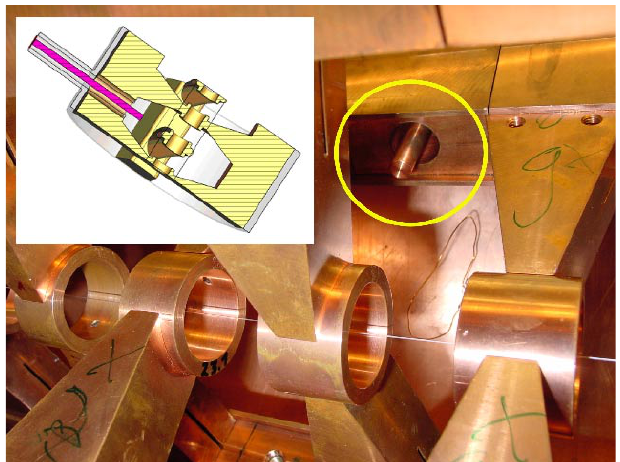
FIG. 14. (Color) The picture shows the favored location of the capacitive coupler during investigations with the room tempera- ture copper model.